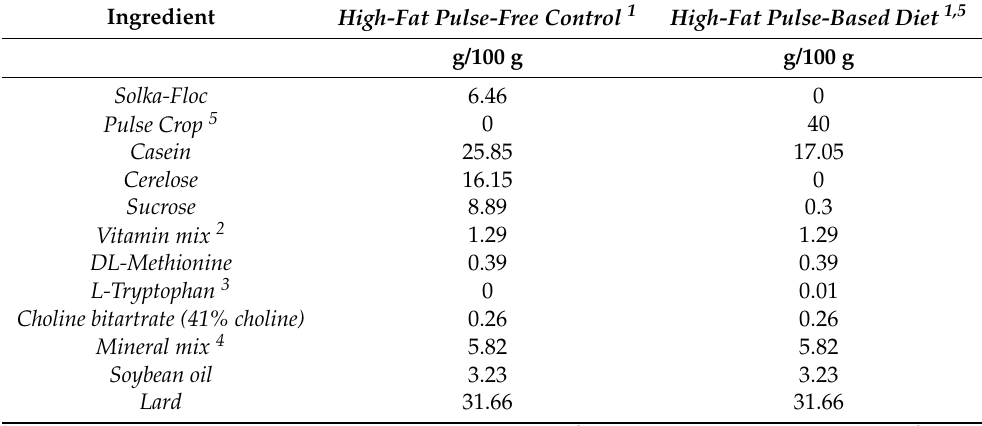
Table 1. Formulations of experimental